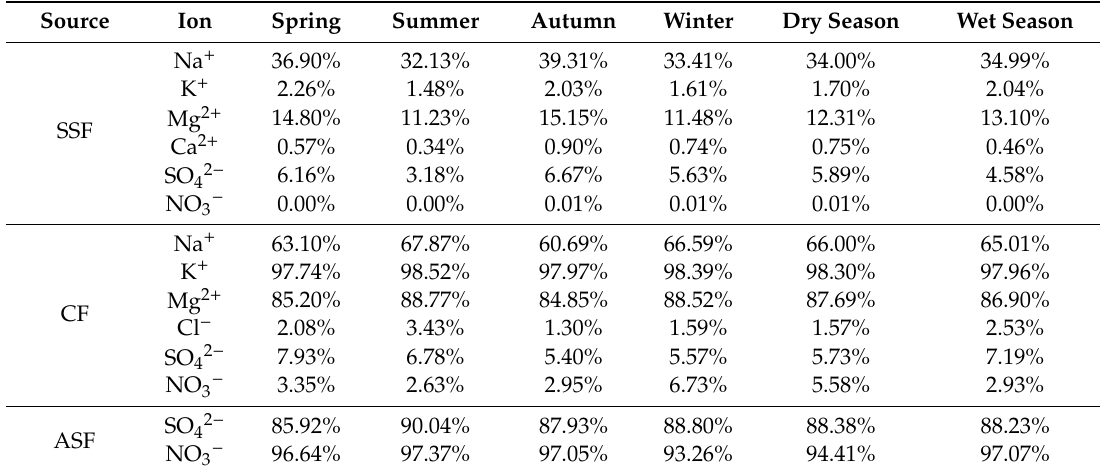
Table 10. Seasonal variation of the contribution rate of the main ion